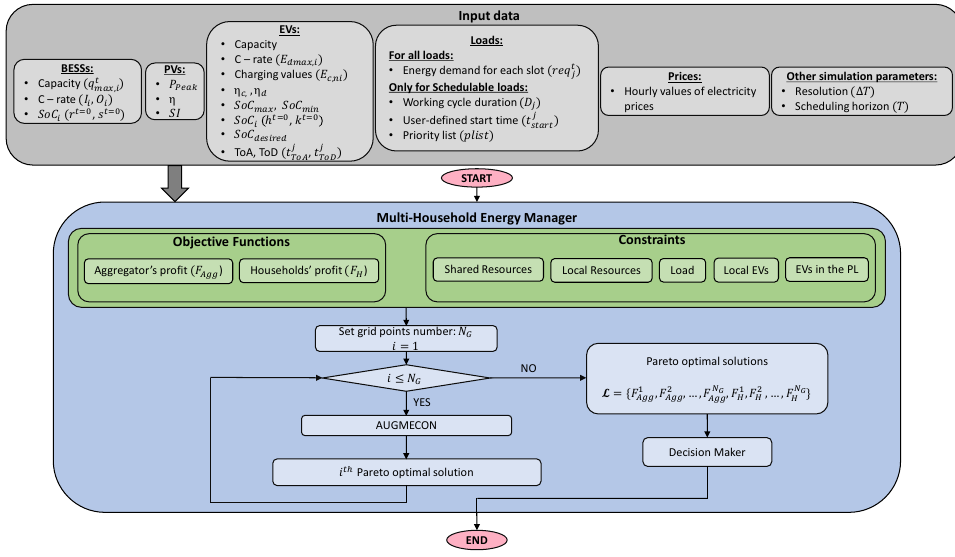
Figure 2. Flowchart of the proposed MH-EM in this